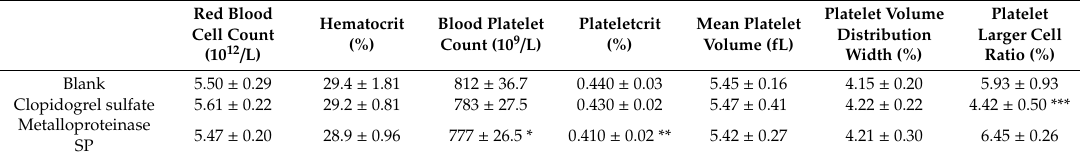
Figure 1. Isolation of metalloproteinase SP from Agkistrodon venom. ( A ) Snake venom (1000 mg) was subjected to Sephadex TM G-75 chromatography (1 × 100 cm) by eluting with 5 mM Tris-HCl (pH 7.4). The fraction III contains the target molecular weight protein. ( B ) Fraction III was further subjected to separation on DEAE-SphadexA-50 column (2 × 150 cm), eluted with 5 mM Tris-HCl (pH 7.4) and a segmented concentration gradient of 0.2 M NaCl. The fraction I contain the target molecular weight protein. ( C ) Fraction I was then separated on Sephadex TM G-75 column (1 × 50 cm), with 5 mM Tris-HCl (pH 7.4). Fraction II of this separation contains the target molecular weight protein. M, marker of protein molecular weight. ( D ) The peptide sequence of targeted protein. Red colors indicated unique peptides identified by LC-MS / MS, matching to targeted protein. Table 1. Hemodynamic examination of arterial blood in clopidogrel and metalloproteinase SP treated mice.